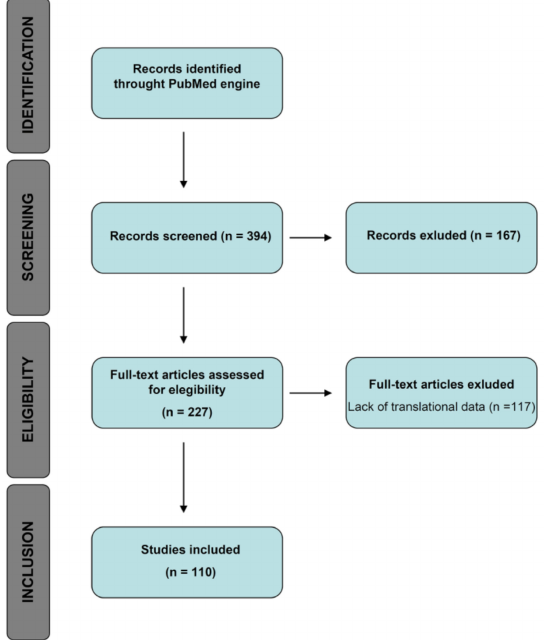
Figure 5. Flowchart of study